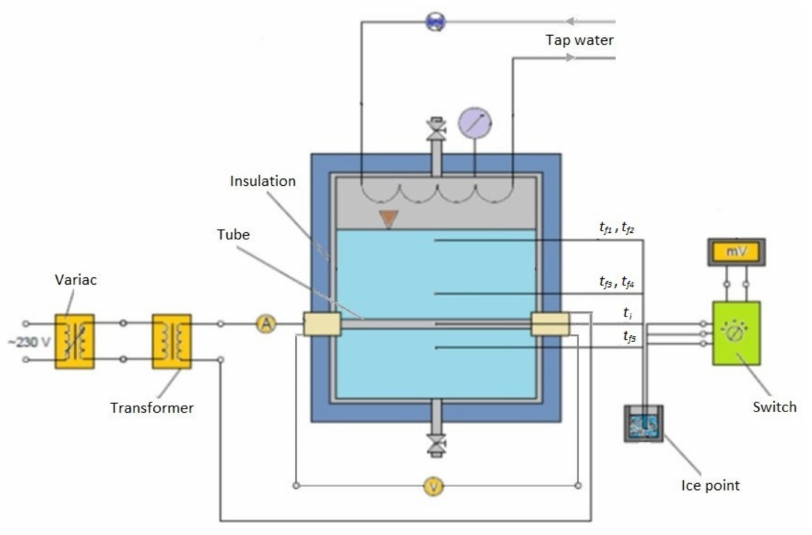
Figure 1. Scheme of the experimental